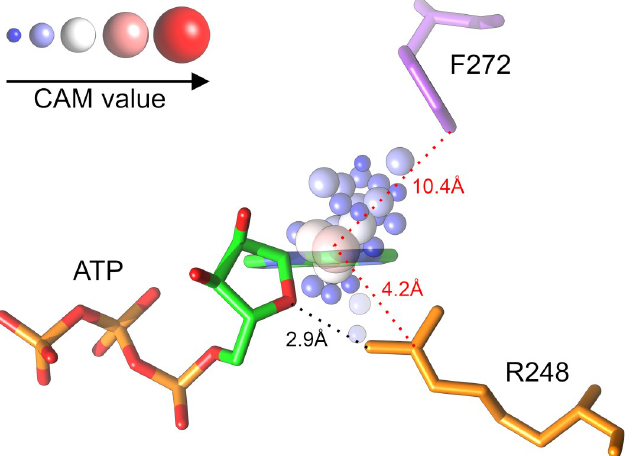
Fig 3. An example of class-activation map (CAM) grids within ligand-binding sites. ATP bound to the human TRPV4 ankyrin repeat domain is shown as sticks colored by atom type (C–green, O–red, N–blue, and P–orange). Selected grid points are represented by spheres whose size and color depend on the assigned CAM value according to the scale in the top left corner. Two residues are shown, R248 (orange) forming a hydrogen bond with the ribose moiety of ATP and a more distant residue F272 (purple). A dotted black line represents a hydrogen bond, whereas dotted red lines mark the distance between protein residues and the highest-scoring grid